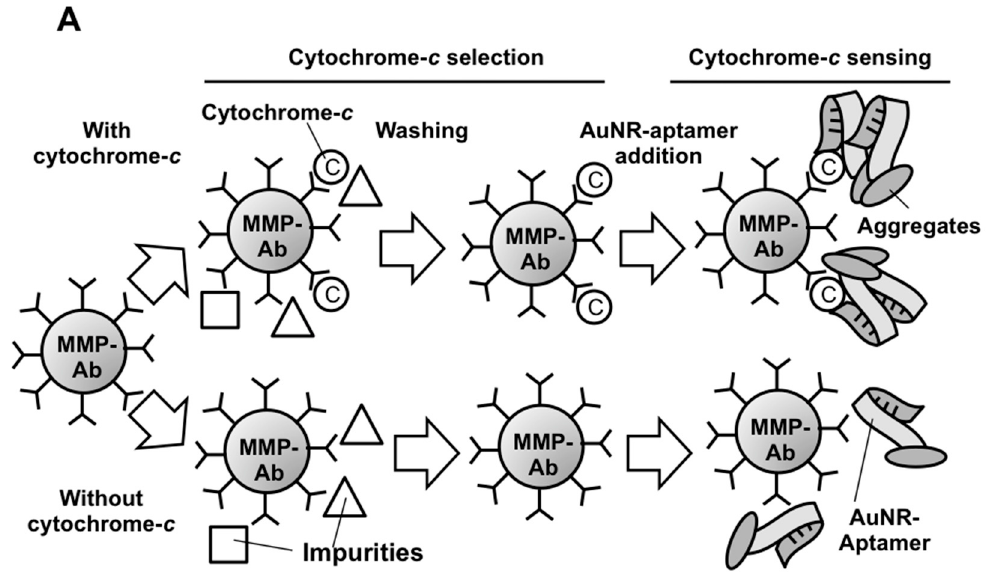
Figure 1. Gold nanorod localized surface plasmon resonance (AuNR-LSPR) assay for cyto- c sensing. A schematic diagram showing the procedures in our AuNR-LSPR assay. Cytochrome- c (Cyto- c ) molecules in the serum were firstly grabbed specifically by cyto- c capturing Abs on functionalized micro-magnetic particle (MMP) surface. After washing under a magnetic field, AuNR-functionalized DNA aptamers against cyto- c were added to generate ((MMP-Ab)-(cyto- c )-(AuNR-aptamer)) sandwich complexes. The change in the absorbance spectrum due to the LSPR effect was recorded.